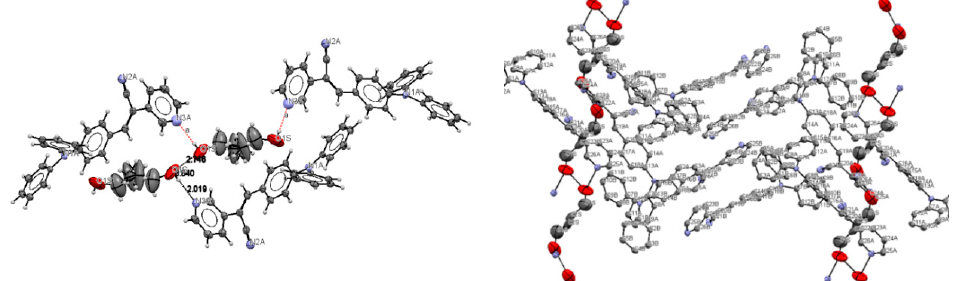
Figure 3. Two conformers A and B for the structure I . Figure 4. Intermolecular hydrogen bond interactions between the lattice solvent molecules (donor) and conformers A (acceptor).